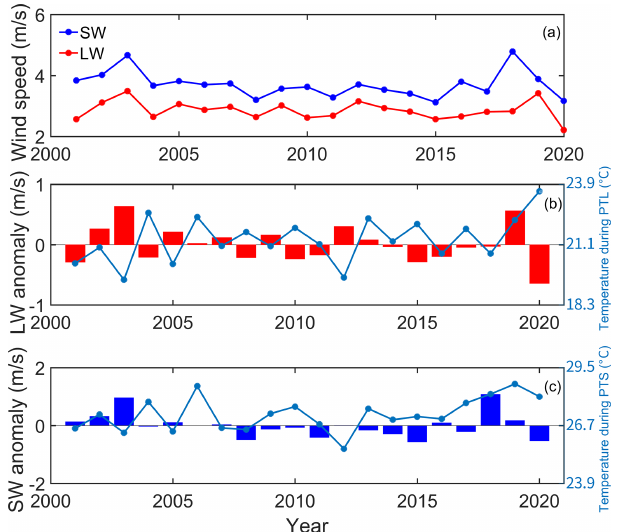
Figure 4. The trends of SW and LW speeds (a) , the LW speed anomaly and land temperature during night-time (b) and the SW speed anomaly and land temperature during daytime (c) based on their monthly average during January from 2001 to